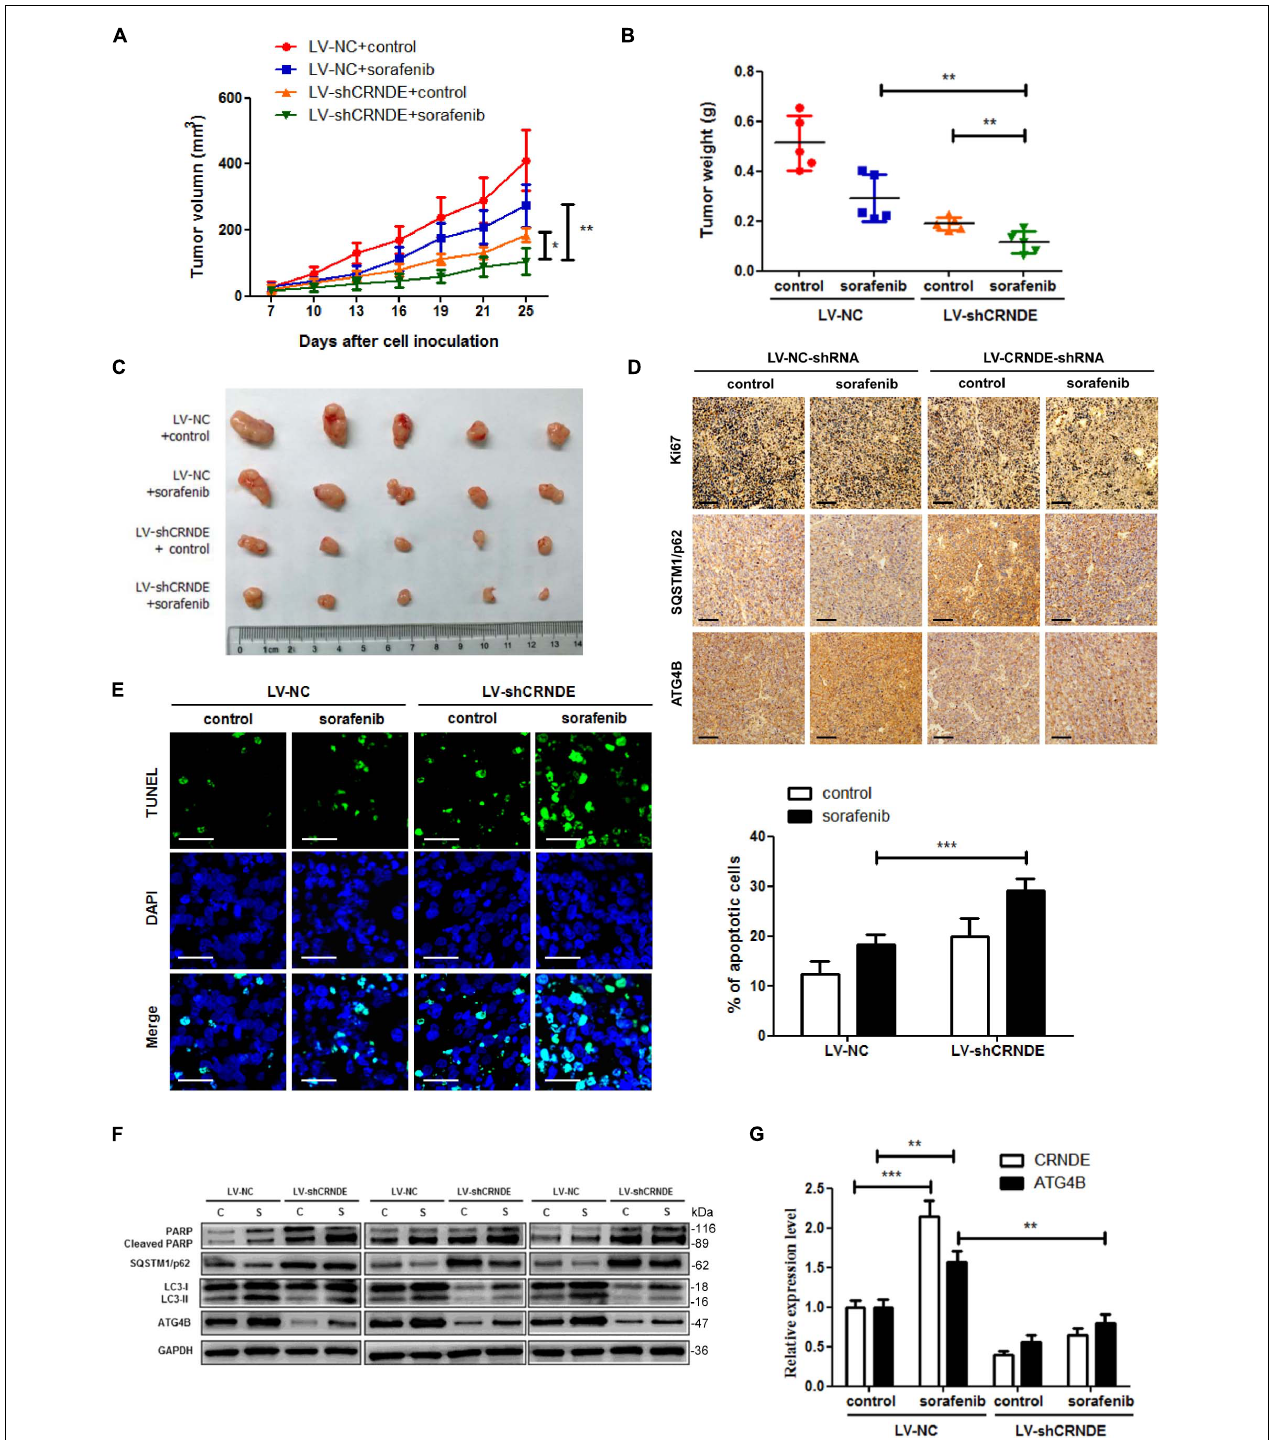
FIGURE 7 | Knockdown of CRNDE sensitizes HCC cells to sorafenib in vivo . (A–C) The size, weight and photograph of xenograft tumors in the groups with or without stable knockdown of CRNDE (LV-shCRNDE or LV-NC) and administration of sorafenib ( n = 5). (D) Immunohistochemical staining assay for Ki67, SQSTM1/p62 and ATG4B in the xenograft tumors of different groups as in panel (A) (scale bar: 100 µ m). (E) TUNEL staining assay for apoptosis in the xenograft tumors of different groups as in panel (A) (scale bar: 20 µ m). (F) Western blot analysis of cleaved PARP, SQSTM1/p62, LC3, and ATG4B in 3 xenograft samples of each group as in panel (A) . (G) qPCR analysis of CRNDE and ATG4B mRNA in the xenograft tumors of different groups as in panel (A) . C, control; S, sorafenib. * P < 0.05; ** P < 0.01; *** P < 0.001.